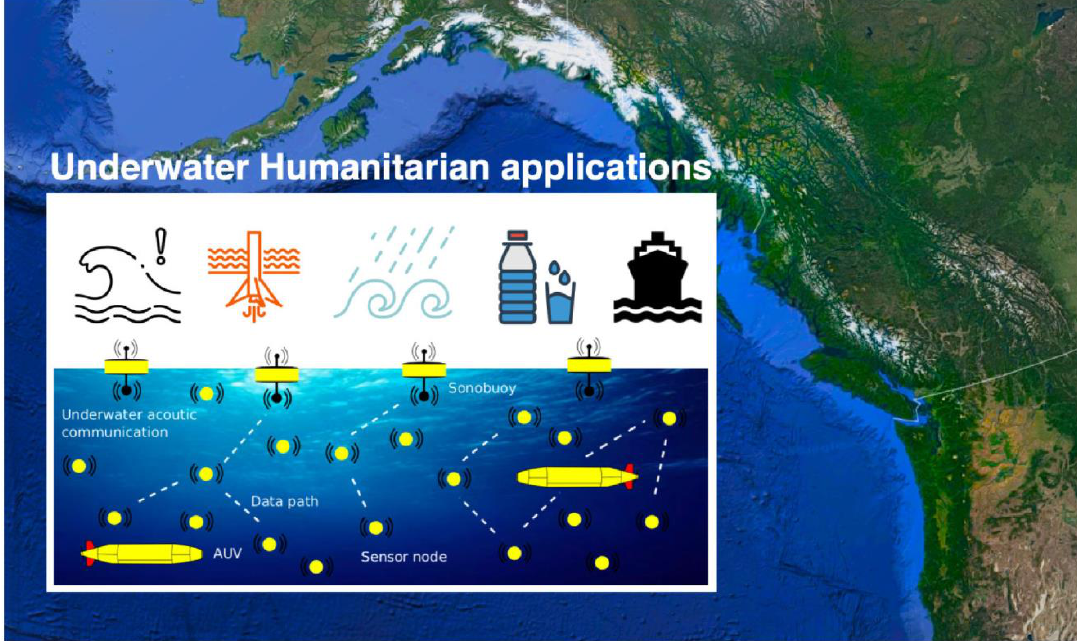
Figure 12. Example of underwater humanitarian applications [100].